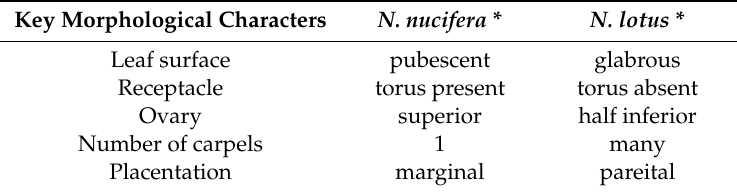
Table 1. The key characteristics that can be easily observed from morphology of living specimens and helpful for species identification between N. nucifera vs. N. lotus living